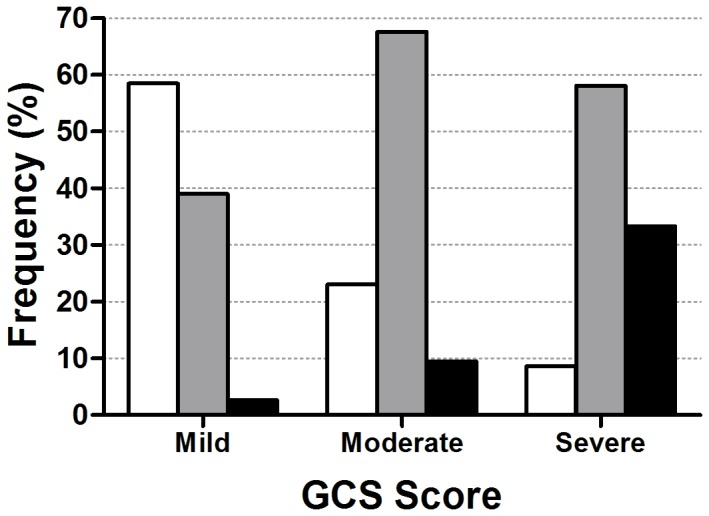
The association between GCS and AIS-HR scores among children who suffered early childhood traumatic head injury.Bars represent AIS-HR scores, so that the darker the bar the more serious the radiological injury: mild–moderate (white), serious–severe (gray), and critical (black) (n=594). Overall, the two scales were associated as per non-parametric Spearman’s rank correlations (ρ=-0.46; p<0.001).